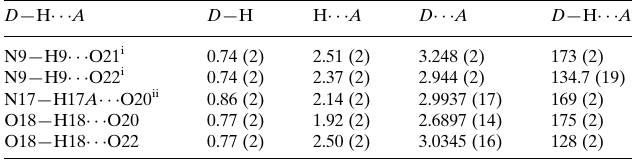
Hydrogen-bond geometry (A˚ , (cid:2)